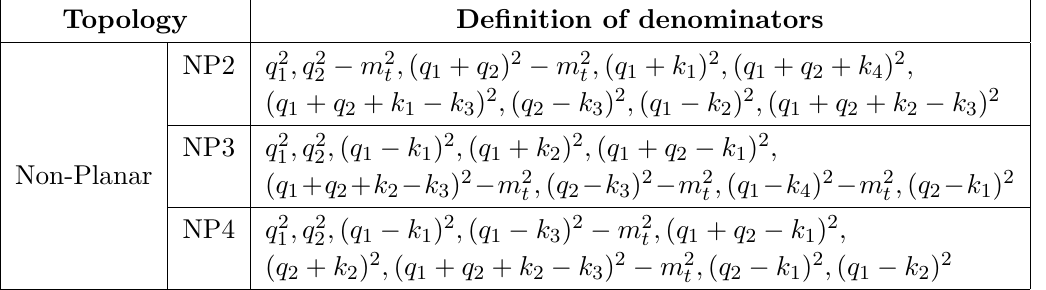
Table 1. The denominators of the master integrals in NP2, NP3 and NP4